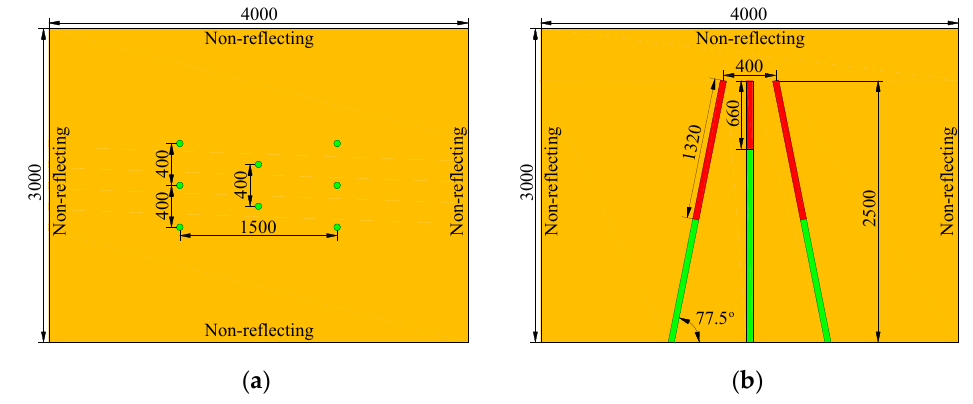
Figure 4. Numerical calculation model (unit: mm): ( a ) front view and ( b ) vertical view.